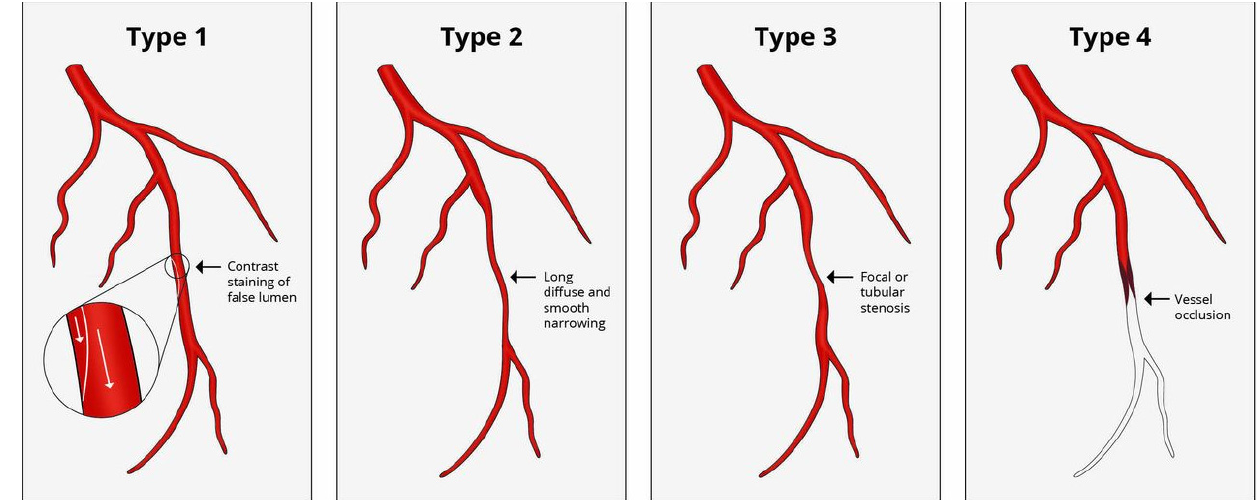
Figure 1. Angiographic spontaneous coronary artery dissection classification proposed by Saw et al. [17].